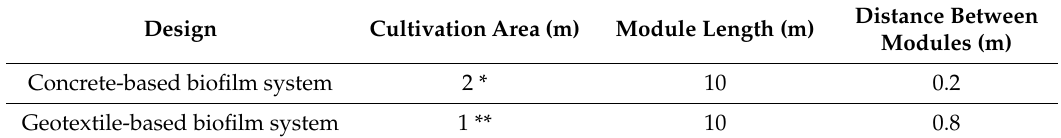
Table 2. Design parameters of microalgal biofilm modules for a large ‐ scale WWT P removal system.